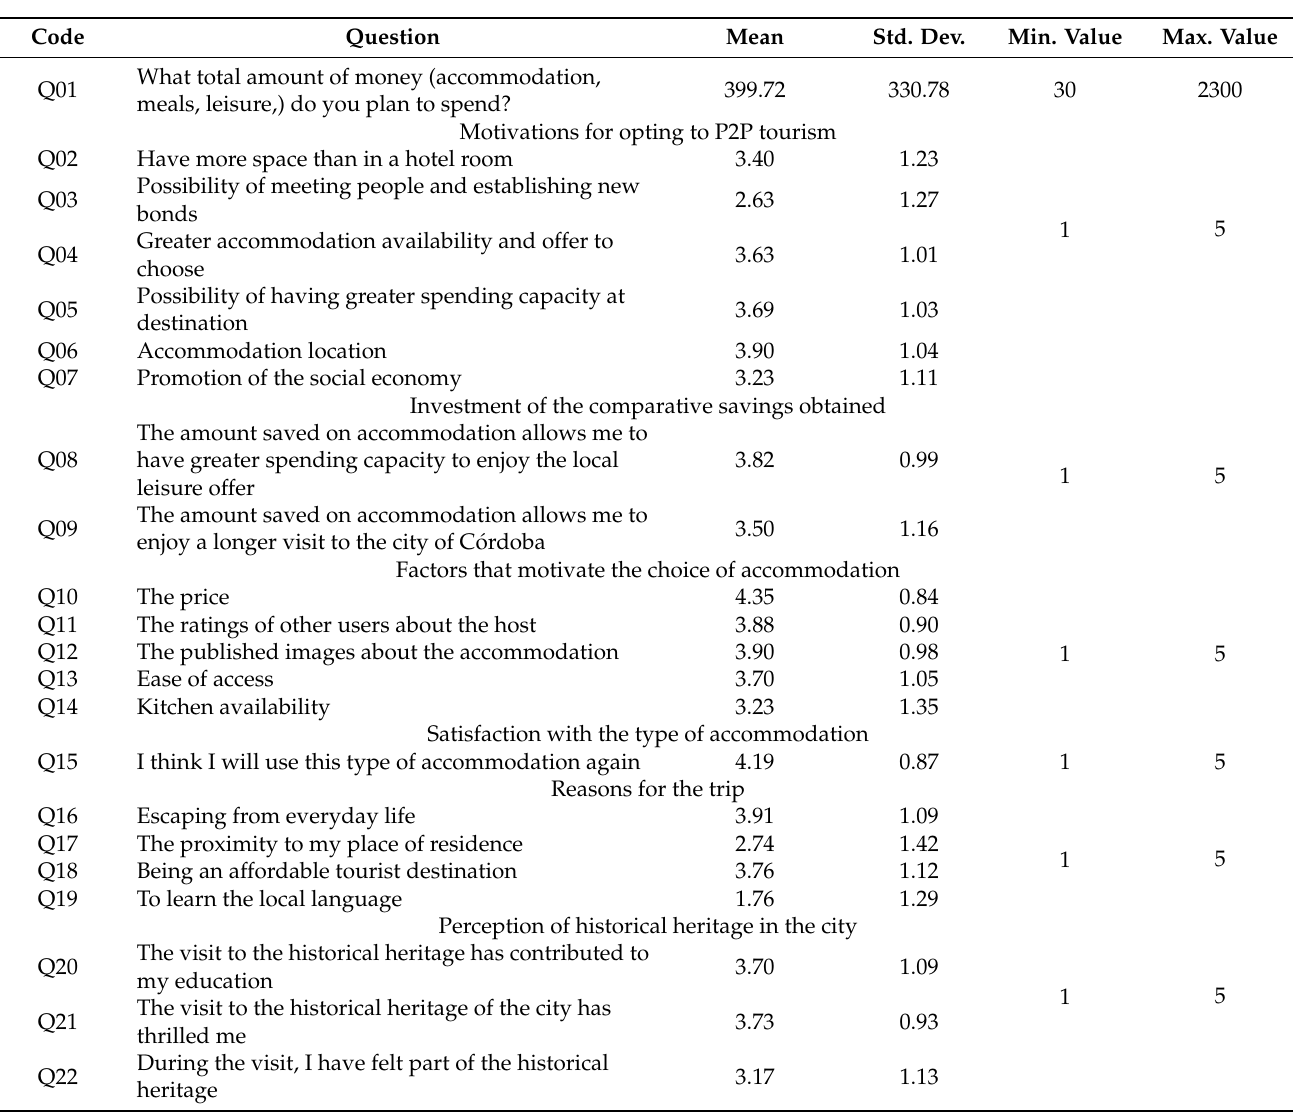
Table 2. P2P tourism in C ó rdoba question